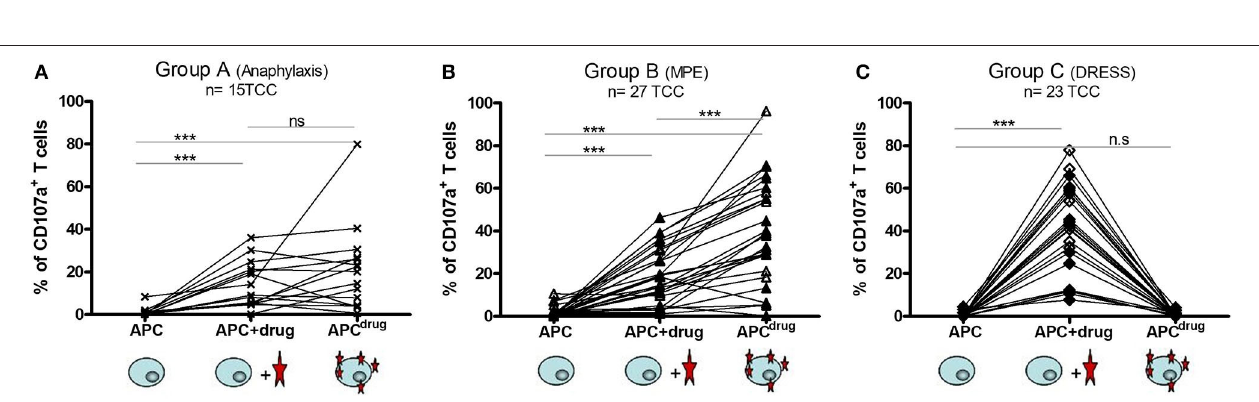
FIGURE 2 | T cells from type I hypersensitivity and maculopapular exanthema (MPE) react according to hapten mechanism and T cells from drug reaction with eosinophils and systemic symptoms (DRESS) react according to p–i concept. The stability/lability of the antigen stimulating complex was analyzed for TCC from patients from group A, B, and C. Each T-cell clone (TCC) was stimulated separately with autologous EBV-BLCL [antigen-presenting cell (APC)] (for background activity), with EBV-BLCL previously pulsed overnight with the culprit β -lactam (APC drug ), and with EBV-BLCL and β -lactam solubilized in CM (APC + drug). After 6h, upregulation of the activation marker CD107a was analyzed by flow cytometry. An increase in the intensity of CD107a expression demonstrates the activation of the TCC. TCC reacting according to p–i concept are meant to react to APC + drug only, whereas TCC reacting according to the hapten mechanism are meant to react to APC drug and/or APC + drug. (A) 15 TCC from 3 patients were analyzed, 12 showing reactivity for amoxicillin and 3 for cefuroxime. (B) 27 TCC from 4 patients (MPE) were analyzed, all showing reactivity to amoxicillin. (C) 23 TCC from 3 patients of DRESS were analyzed, with 6 reacting to amoxicillin and 17 to ceftriaxone. The plots with single reactivity (amoxicillin, cefuroxime, or ceftriaxone) are shown in the Supplementary Figure .